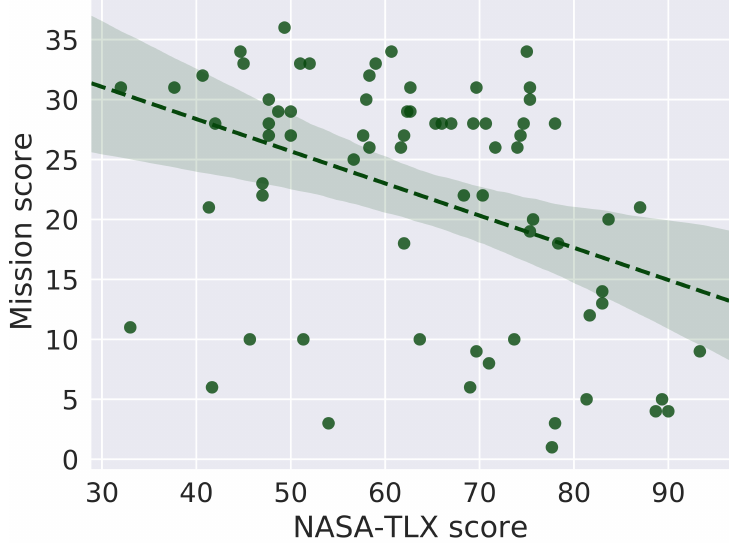
Figure 4. Final mission score versus NASA-TLX score. Each plotted point relates to one of the 72